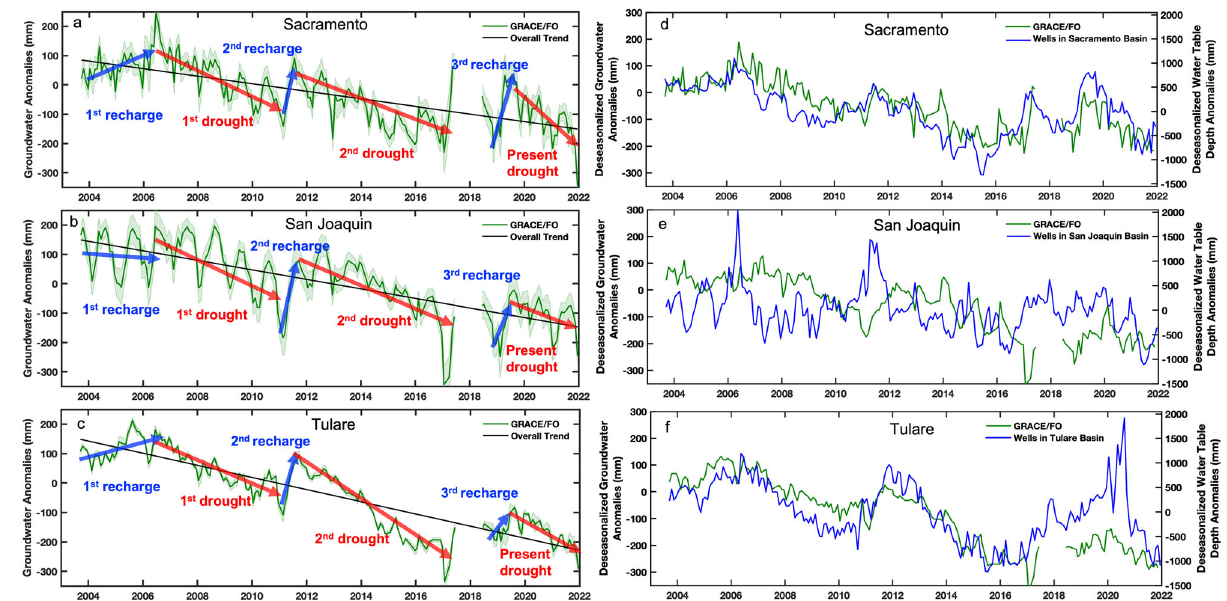
Fig. 6 | Groundwater storage variations in the three Central Valley sub-basins. GRACE/FO-derived groundwater anomalies during September 2003 – December 2021inthe( a )Sacramento,( b )SanJoaquin,and( c )Tularebasins.Thegreenshaded margins are the uncertainty of groundwater storage estimates. Red arrows repre- sent groundwater loss trends during the droughts of 2006 – 2011, 2011 – 2017, and